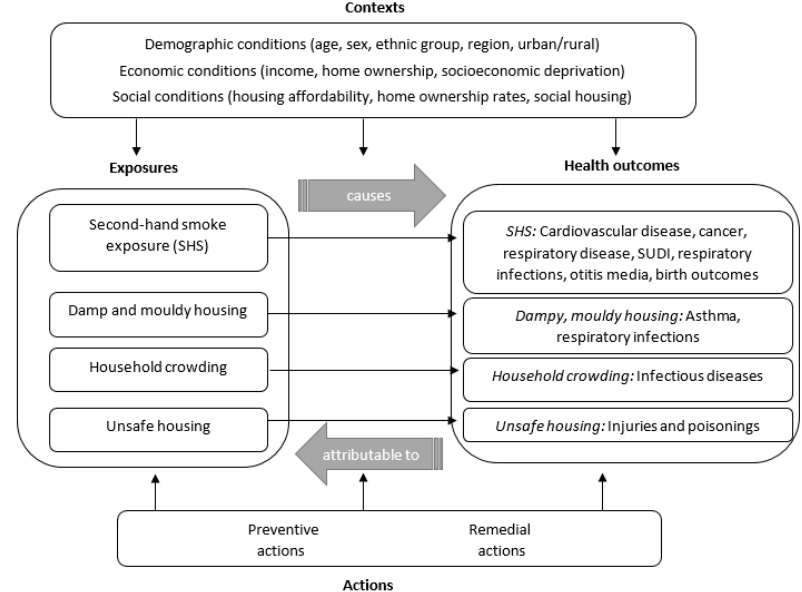
Figure 2. The multiple exposures multiple effects (MEME) framework, applied to the indoor environment. Source: Adapted from Briggs [2]. SUDI: sudden unexpected death in infancy.